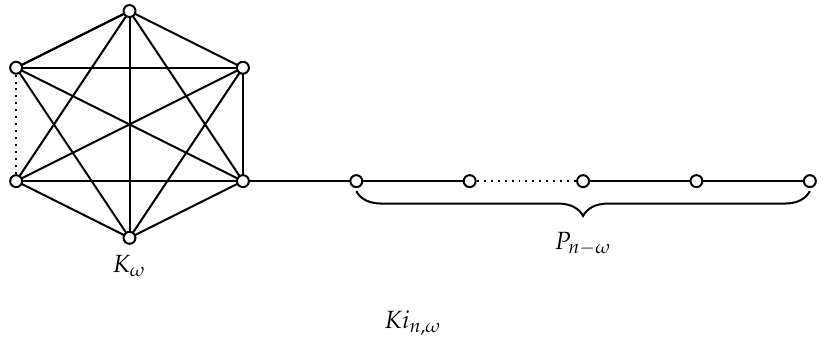
Figure 1. The long kite graph Ki n , ω